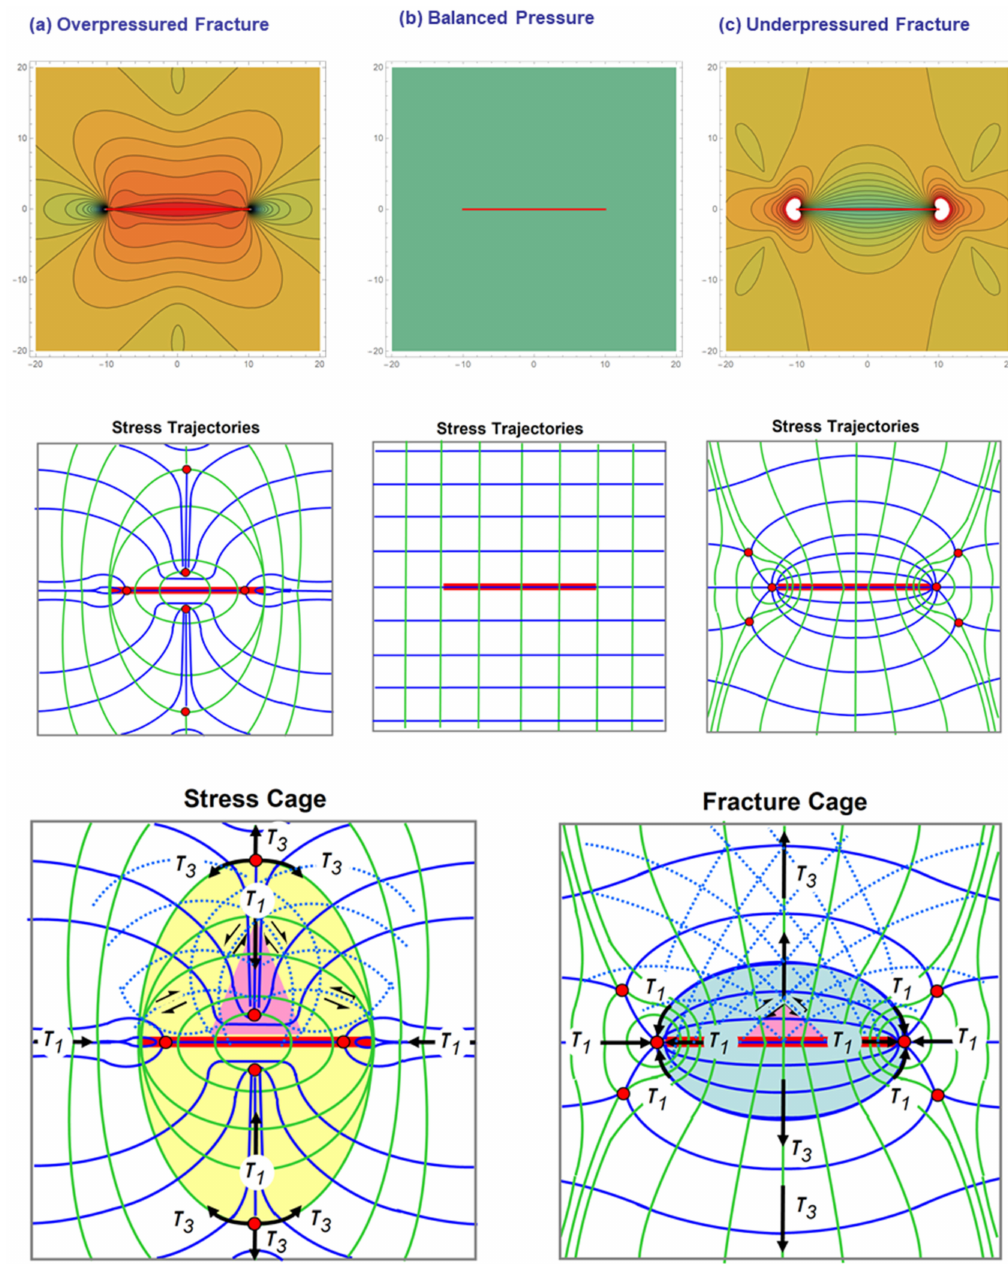
Figure 13. Stress magnitude contours ( top row), principal stress trajectories ( middle row), and slip lines (dashed in blue, bottom row) for ( a ) over-pressured, ( b ) balanced, and ( c ) under-pressured hydraulic fractures. Red dots are neutral points and red curves outline the fracture cage (in a ) and stress cage (in c ). Blue trajectories are for the largest principal stresses (deviatoric compression τ 1 = σ 1 − P ). Green trajectories are for smallest principal stresses (deviatoric tension, τ 3 = σ 3 − P ). The yellow ellipse on the bottom left outlines the stress cage. The blue ellipse on the bottom right outlines the fracture cage. The pink triangle shows the potential breakout